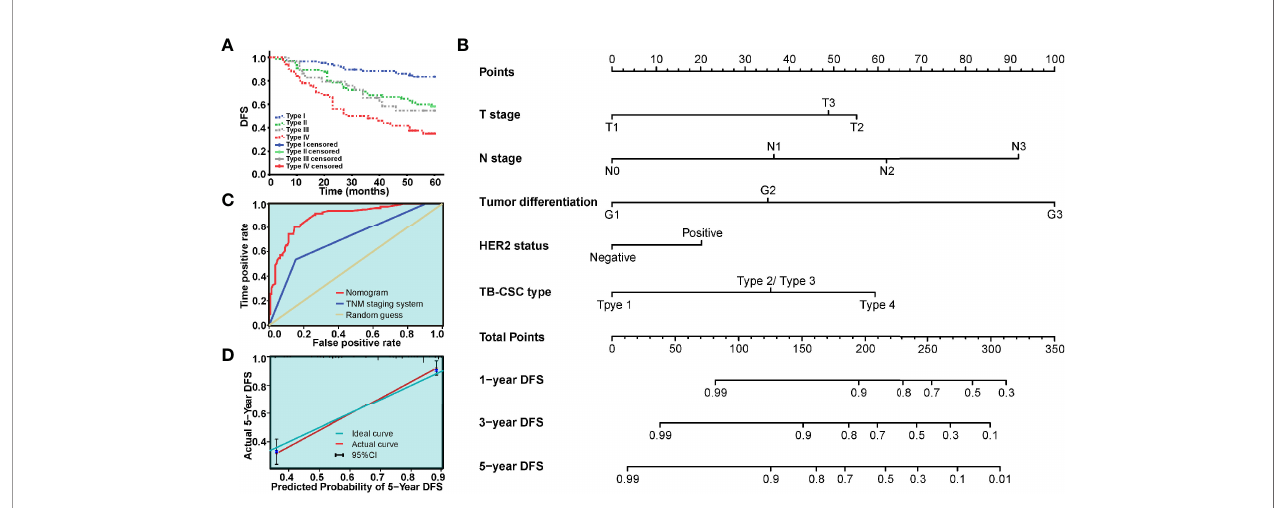
FIGURE 4 | The model based on TB-CSC type for predicting tumor recurrence in patients with BC. (A) The Kaplan-Meier survival curve shows DFS after strati fi cation by TB-CSC type. (B) The nomogram based on TB-CSC type predicting DFS probability of BC patients. (C) Calibration plot showing favorable agreement between the predicted rate (red line) and actual rate (green line). (D) The ROC curve shows a better prognostic value of nomogram on recurrence than TNM staging